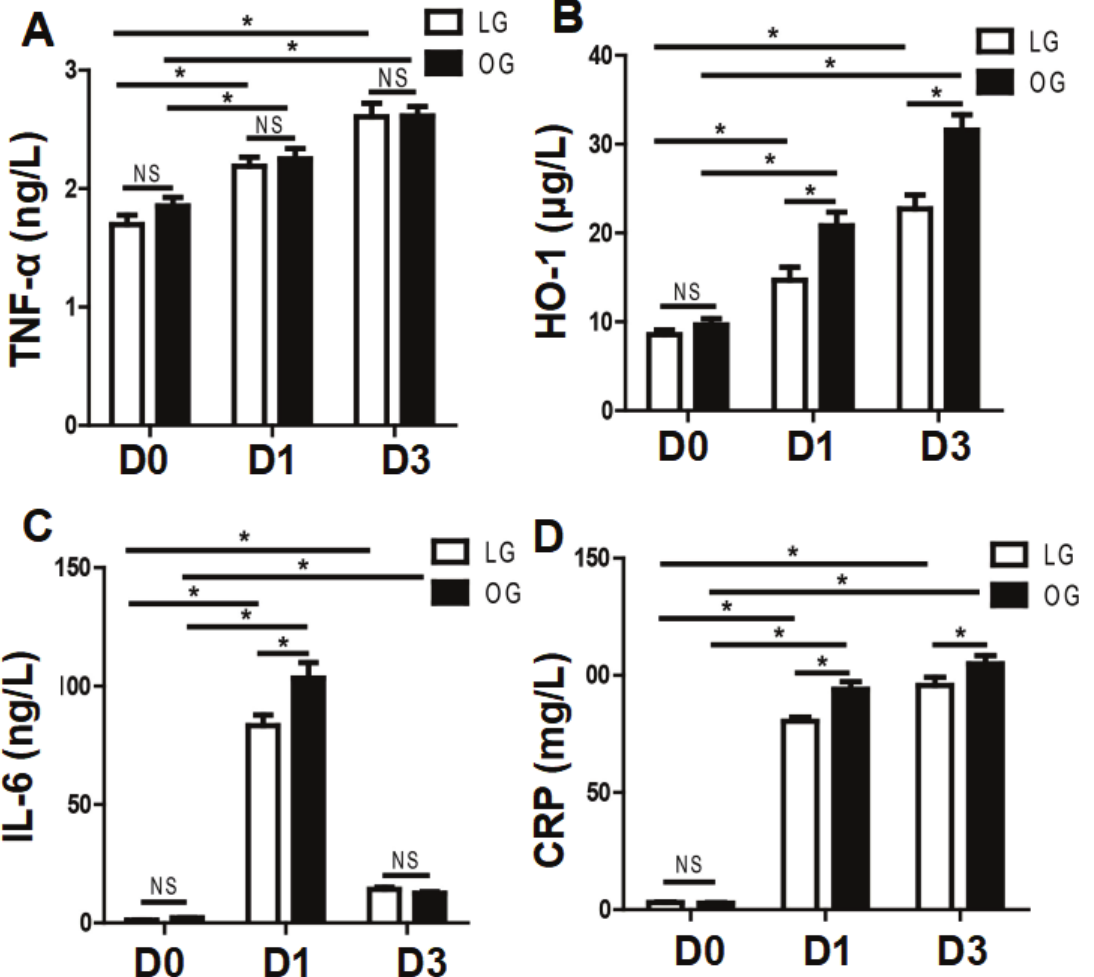
Figure 1: Level difference of serum TNF-α, HO-1, IL-6 and CRP pre- and post-operation in laparoscope group (LG) and open surgical group (OG). A. serum TNF-α difference pre- and post-operation in LG and OG; B. serum HO-1 difference pre- and post-operation in LG and OG; C. serum IL-6 difference pre- and post-operation in LG and OG; D. serum IL-6 difference pre- and post-operation in LG and OG. * stands for P<0.05. NS stands for no significant difference